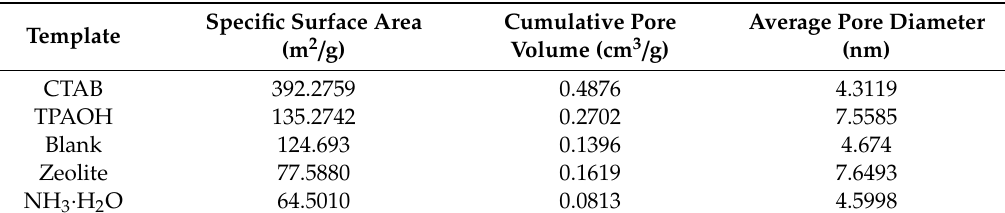
Table 1. The results of specific surface areas, pore volumes, and pore diameters of porous materials with different templates (Blank, TPAOH, CTAB, NH 3 ·H 2 O, and Zeolite were used, respectively, instead of the Cu-Al/SiO 2 porous materials with no template added, tetrapropylammonium hydroxide (TPAOH), cetyltrimethylammonium bromide (CTAB), ammonium hydroxide (NH 3 ·H 2 O), and zeolite seed crystal).